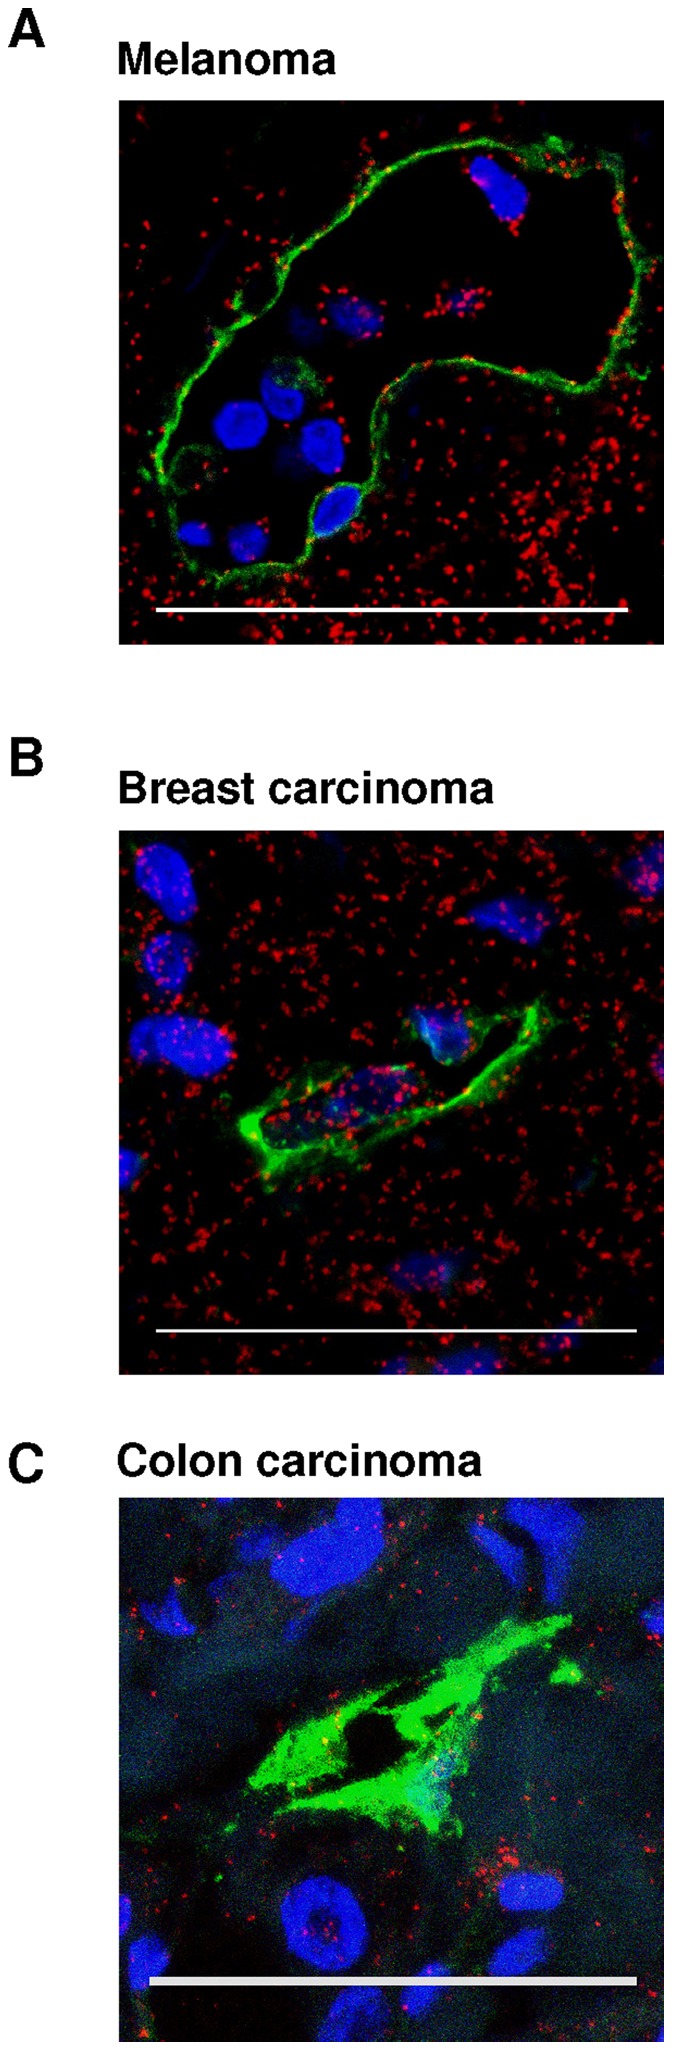
Direct interaction between PI3K p85 and VEGFR-3 in metastatic melanoma (A), breast (B) and colon (C) cancers.PI3K p85/VEGFR-3 complexes (red) detected by in situ PLA in tumor cells and lymphatic vessels (green, podoplanin). Bar, 50 µm. Nuclei stained with DAPI (blue).